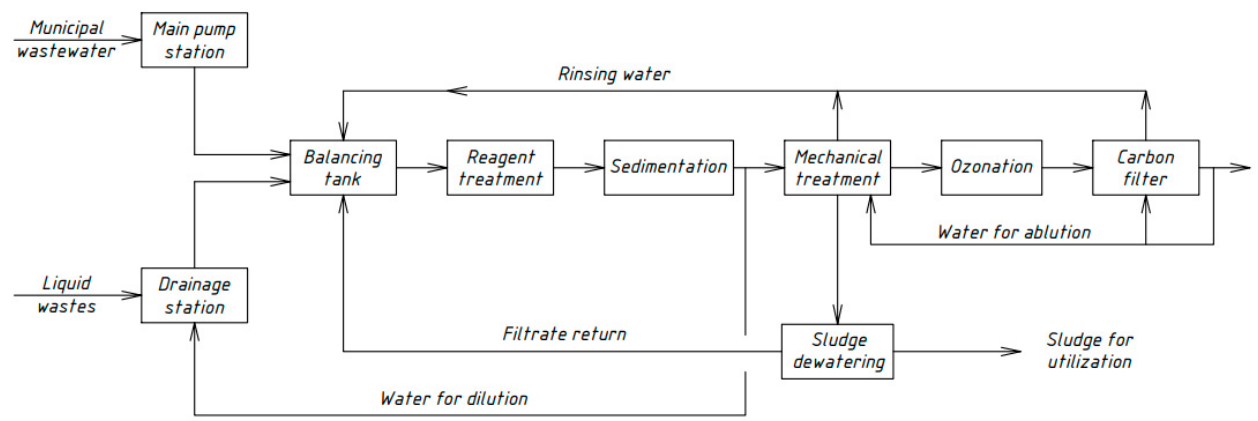
Figure 5. Wastewater treatment scheme with an ozonation unit.